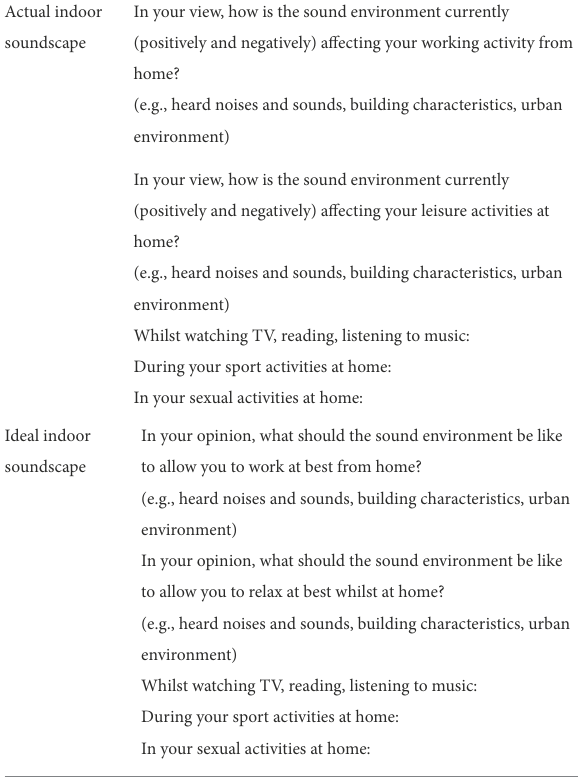
TABLE 1 Excerpts of the open-ended questions included in the